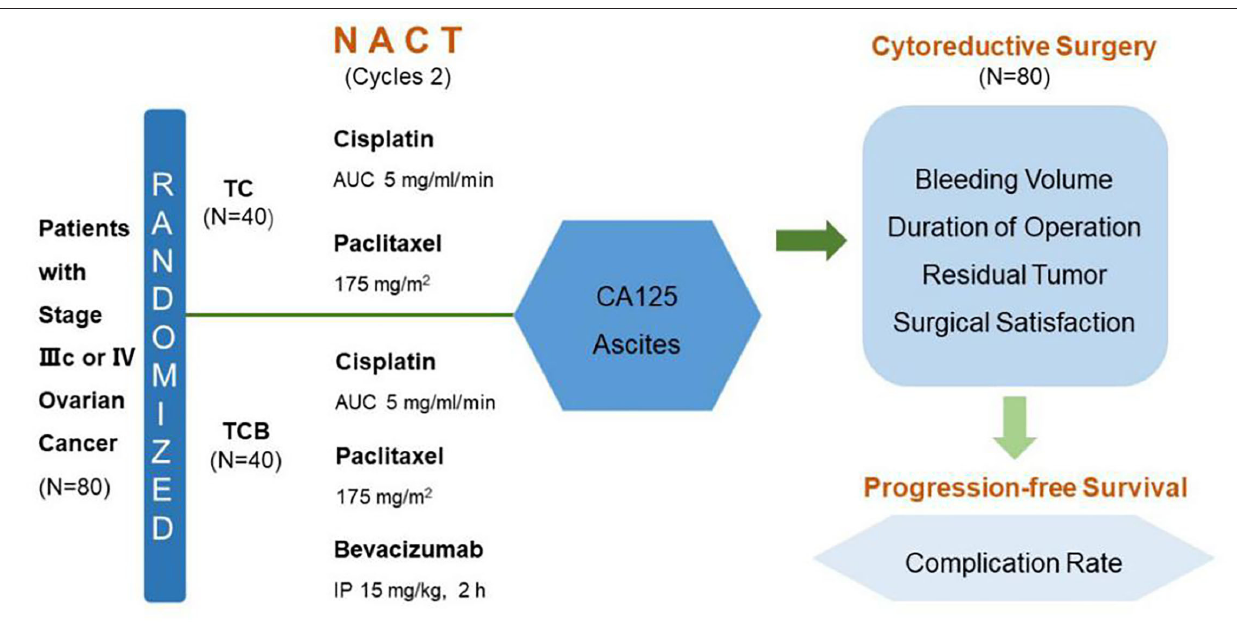
FIGURE 2 | Study design. TC, carboplatin plus paclitaxel chemotherapy; TCB, carboplatin plus paclitaxel combined with bevacizumab intraperitoneal, NACT, neoadjuvant chemotherapy; AUC, area under the curve IP, intraperitoneal perfusion. size (satisfactory tumor resection was defined as tumors with residual area < 1 cm in diameter, and tumors with residual area > 1 cm in diameter were defined as unsatisfactory) were collected and considered the primary indicators for evaluating therapeutic